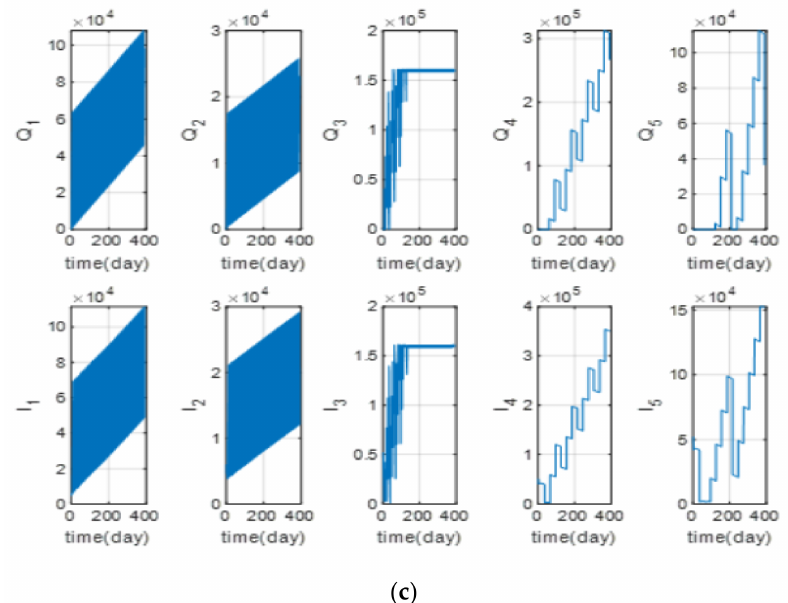
Figure 4. Results of simulation for Topology 2: ( a ) the results of simulated debt value to the bank (first row) and bank financing (second row) for each entity, ( b ) the results of simulated inventory level (first row) and production values (second row) for each entity, and ( c ) the results of simulated profit value (first row) and working capital (second row) for each